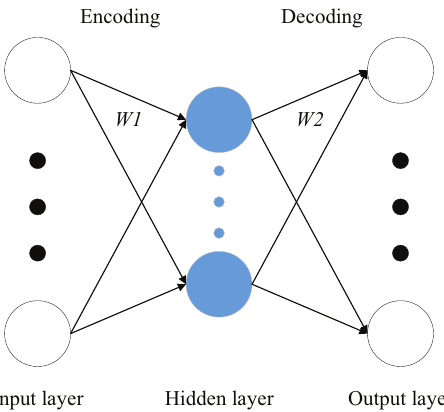
Figure 7. The structure of the traditional Auto-Encoder network